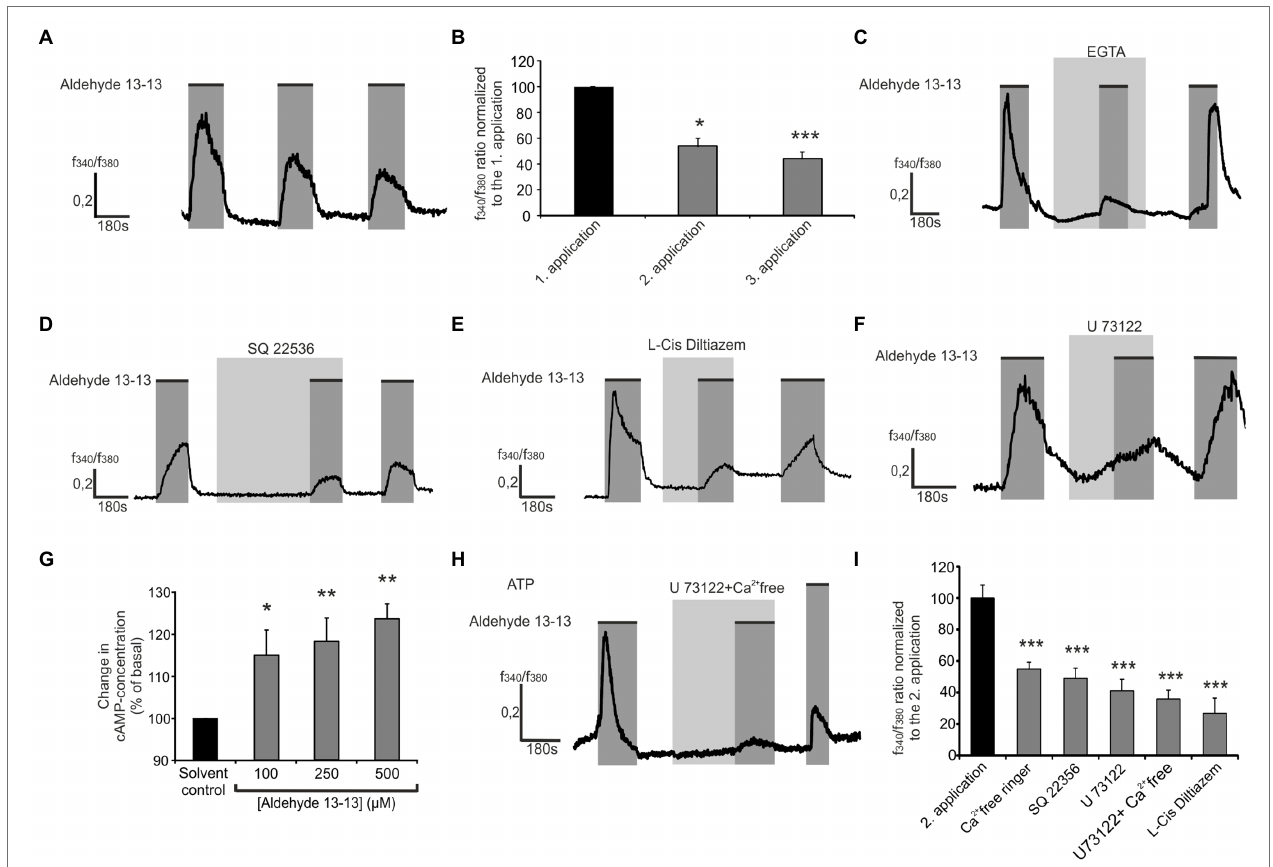
FIGURE 4 | Involvement of the classical olfactory signaling cascade in the aldehyde 13-13 induced increase of intracellular Ca 2+ in Nthy-ori 3-1 cells. (A) Cells were stimulated three times for 3 min with aldehyde 13-13 (500 μ M; marked dark gray). (B) Quantification of the repetitive applications of aldehyde 13-13 ( n = 8). (C) Preincubation with Ca 2+ free ringer’s solution containing 10 μ M EGTA (marked by a light gray box) reduces the aldehyde 13-13 (500 μ M) induced response. Pretreatment with SQ 22536 (10 μ M; D ), L-Cis Diltiazem (100 μ M; E ) or U73122 (5 μ M; F ) reduced the aldehyde 13-13 (500 μ M)-induced Ca 2+ signals in Nthy-ori 3-1. (G) Aldehyde 13-13 increases the intracellular cAMP concentration in a dose-dependent manner in Nthy-ori 3-1 cells. (H) Exemplary trace of aldehyde 13-13 induced response in Nthy-ori 3-1 cells preincubated with the inhibitor U73122 in Ca 2+ free ringer solution. (I) Quantification of aldehyde 13-13-induced Ca 2+ signals in blocker experiments relative to control measurements (the average of the second response to aldehyde 13-13 without an inhibitor). Data significance was calculated using One-way ANOVA with Dunnett’s Post Hoc test or Friedman Test with “Two-stage step-up method of Benjamini, Krieger, and Yekutieli” referring to the aldehyde 13-13 induced Ca 2+ signal in control measurements ( n = 3–12). The mean values are all shown with the corresponding SEM, * p ≤ 0.05, ** p ≤ 0.01, and *** p ≤